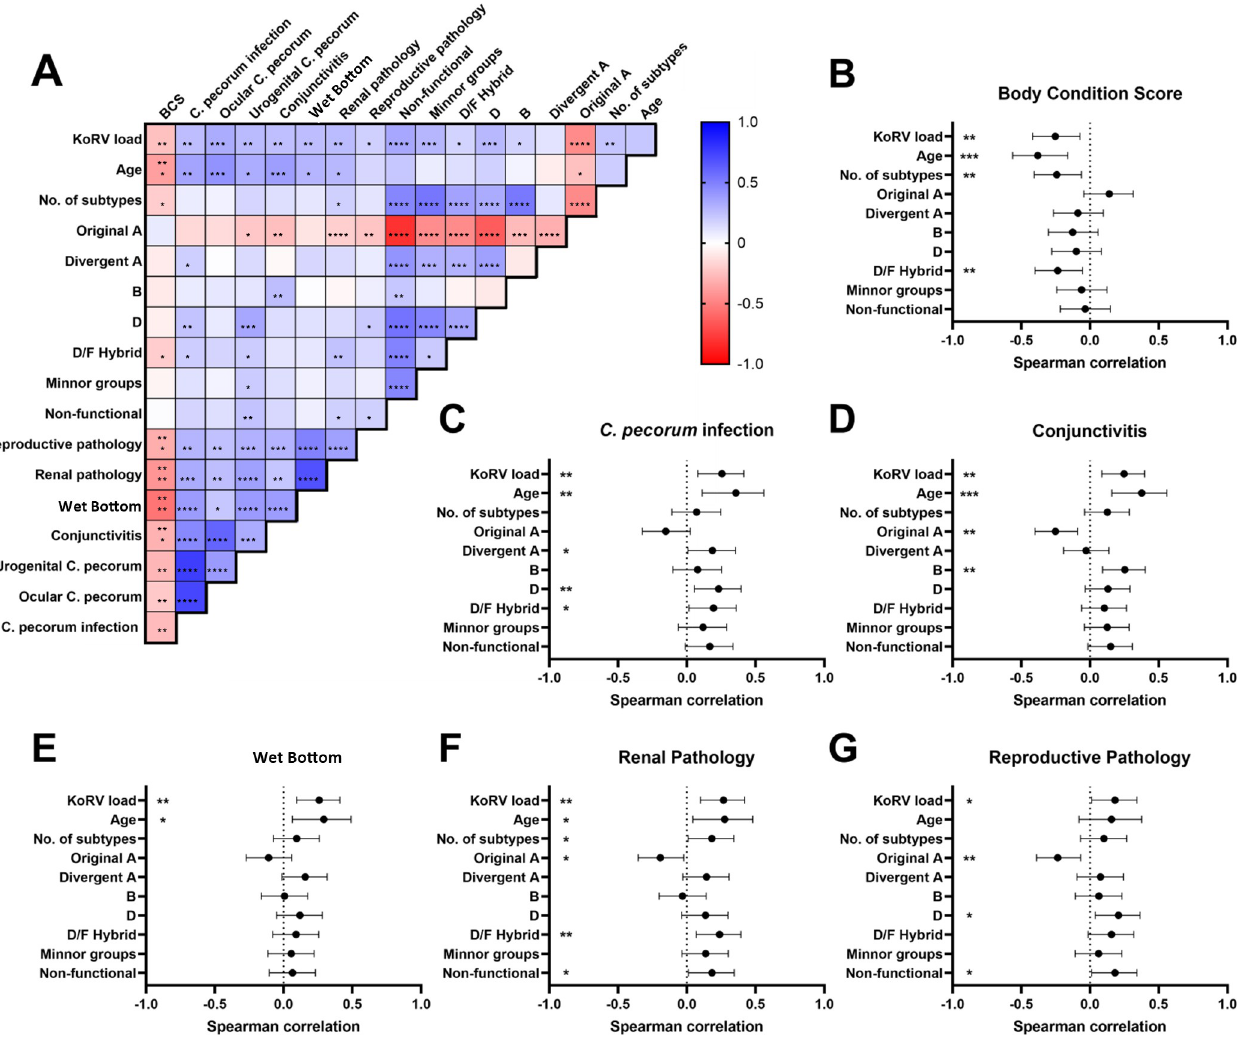
Fig 3. (A) Spearman correlation matrix, with colours representative of strength of correlation; Blue = positive correlation, Red = negative correlation. (B-G) Individual disease pathologies and Spearman correlation data for KoRV parameters; bars represent 95% confidence interval for Spearman correlation. p values � = < 0.05, �� = < 0.01, ��� = < 0.001, ���� = <